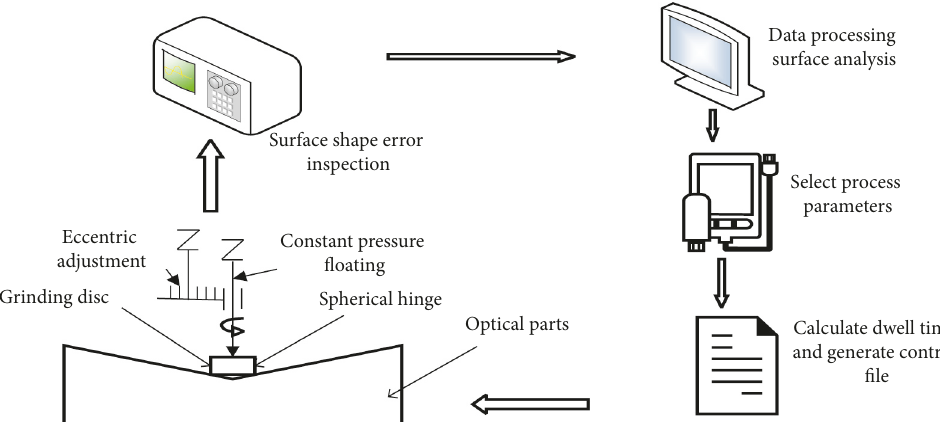
Figure 7: CCOS grinding technology workflow